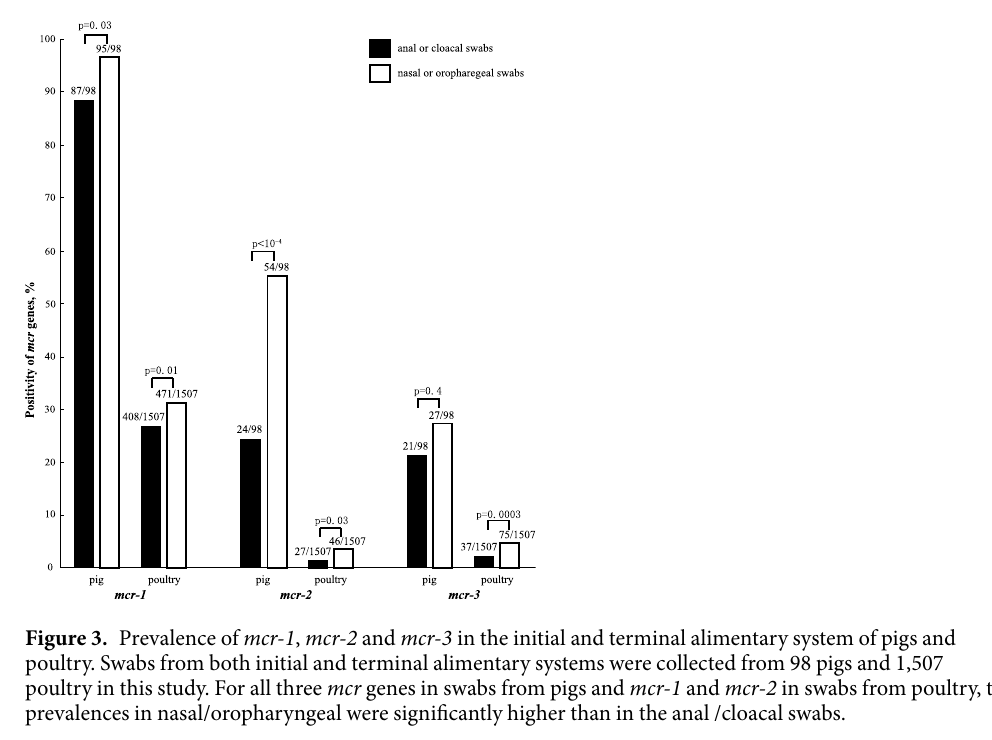
4 SCIEntIFIC REPORtS | (2018) 8:3705 | DOI:10.1038/s41598-018-22084-4